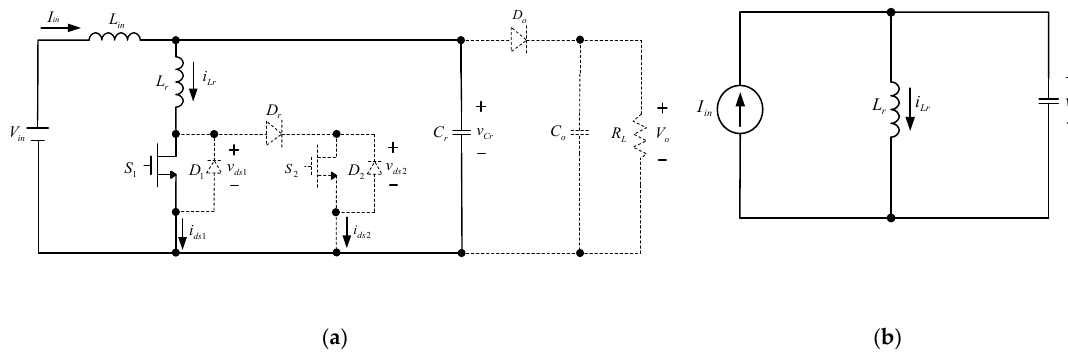
Figure 7. ( a ) Current flow in state 4; ( b ) Equivalent circuit of ( b ).